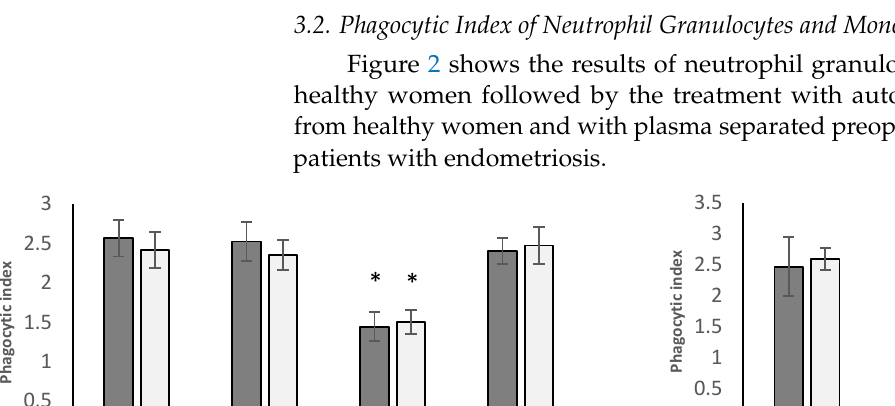
Figure 2. Phagocytic index of neutrophil granulocytes ( a ) and monocytes ( b ) of healthy women followed by the treatment with autologous and heterologous plasma from healthy women and with plasma separated preoperatively and postoperatively from patients with endometriosis. Experiments were performed with inactivated and non-inactivated plasma samples in each group. * p <